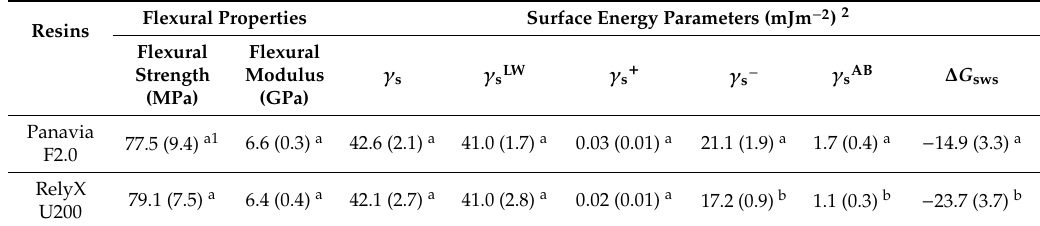
Table 2. Flexural properties and surface energy parameters of the two resins ( n =